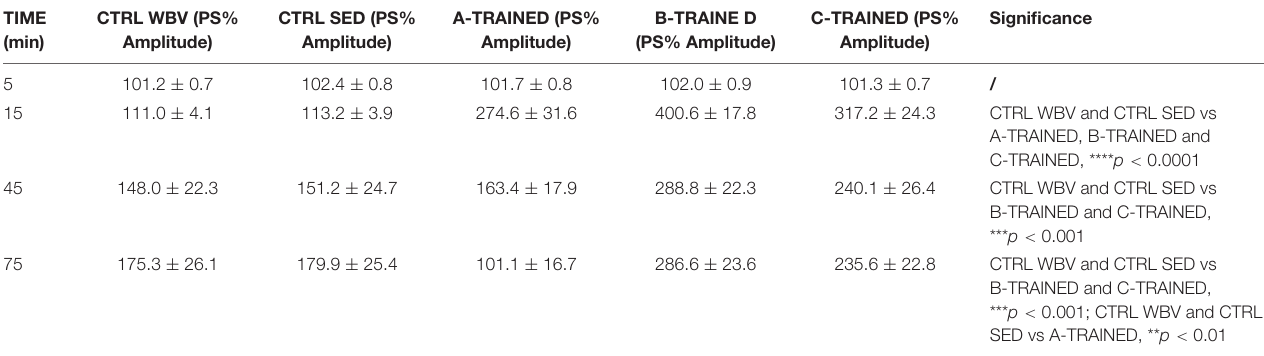
TABLE 1 | Percentage of population spike (PS) amplitude values recorded in the CA1 region of hippocampal slices from control and trained groups at different